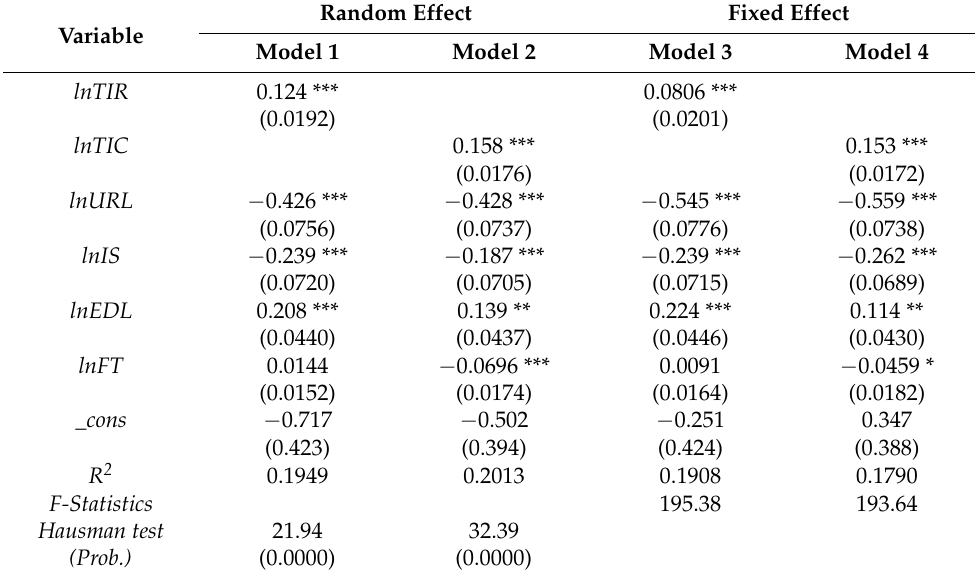
Table 5. Panel regression results for the three major urban